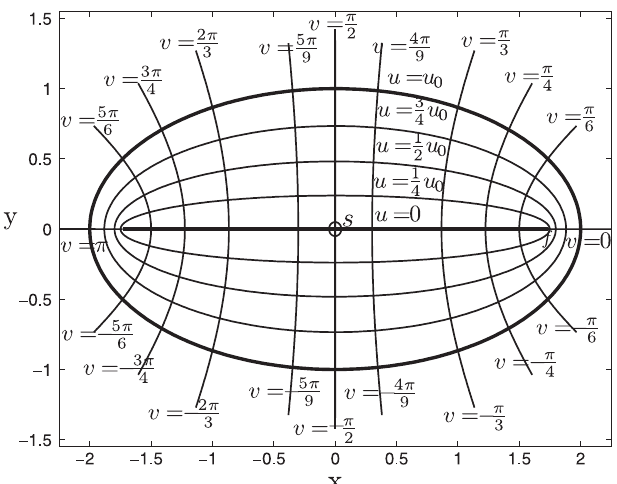
FIG. 2. Elliptic cylindrical (cid:2) u; v; s (cid:3) and a Cartesian orthogonal (cid:2) x; y; s (cid:3) coordinates system.